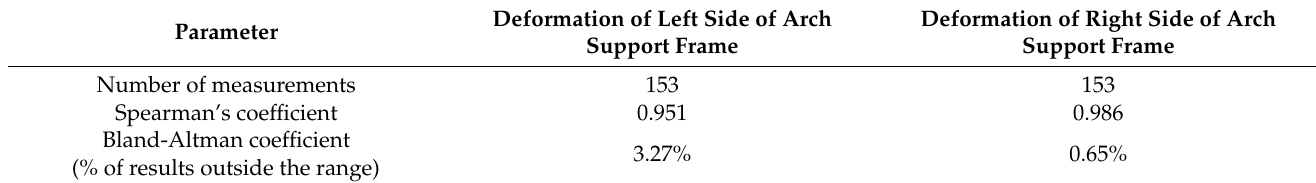
Figure 25. Plot of differences between methods, expressed as percentages of the values vs. the mean of the two measurements (deformation of right side of arch support frame). Table 5. Bland Altman and Spearman correlation coefficient of the values of deformation by differ- ent methods.